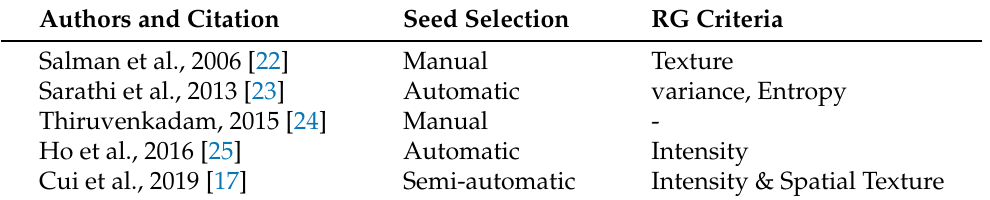
Table 1. Related Work in region growing seed selection and growth